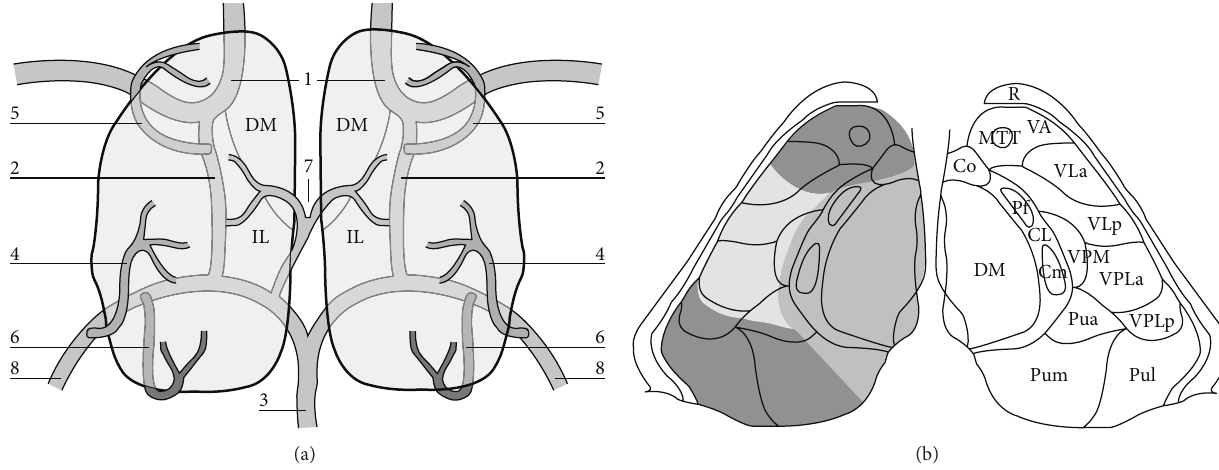
Figure 1: Schematic view of the arterial supply to the thalamus (adapted with permission from [6]). (a) The view from above; (b) detailed relationshipbetweenthearterialterritoriesandnuclearsubgroupswithinthethalamus.1:carotidartery;2:posteriorcommunicatingartery;3: basilar artery; 4: thalamogeniculate arteries; 5: tuberothalamic artery; 6: posterior choroidal artery; 7: paramedian pedicle (AOP); 8: posterior cerebral artery. Main thalamic nuclei and tracts: CL: central lateral; CM: centromedian; Co: commissural; Cp: commissural posterior; DM: dorsomedian; MTT: mammillothalamic tract; Pua: pulvinar anterior; Pum: pulvinar medial; Pul: pulvinar lateral; Pf: parafascicularis; R: reticular; VA: ventral anterior; VLa: ventral lateral anterior; VLp: ventral lateral posterior; VPLa: ventroposterolateral anterior; VPLp: ventroposterolateral posterior; VPM: